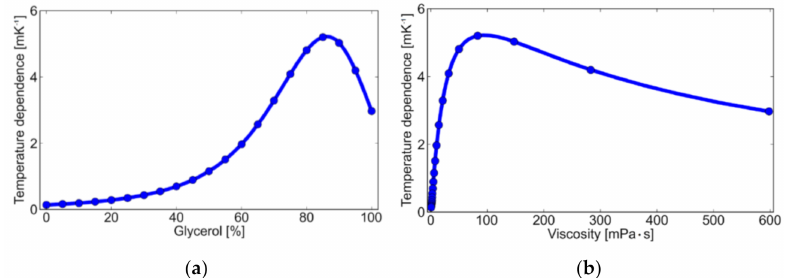
Figure 6. Temperature dependence (absolute value of temperature coefficient) of fluorescein as a function of ( a ) glycerol percentage and ( b ) viscosity of the solution.